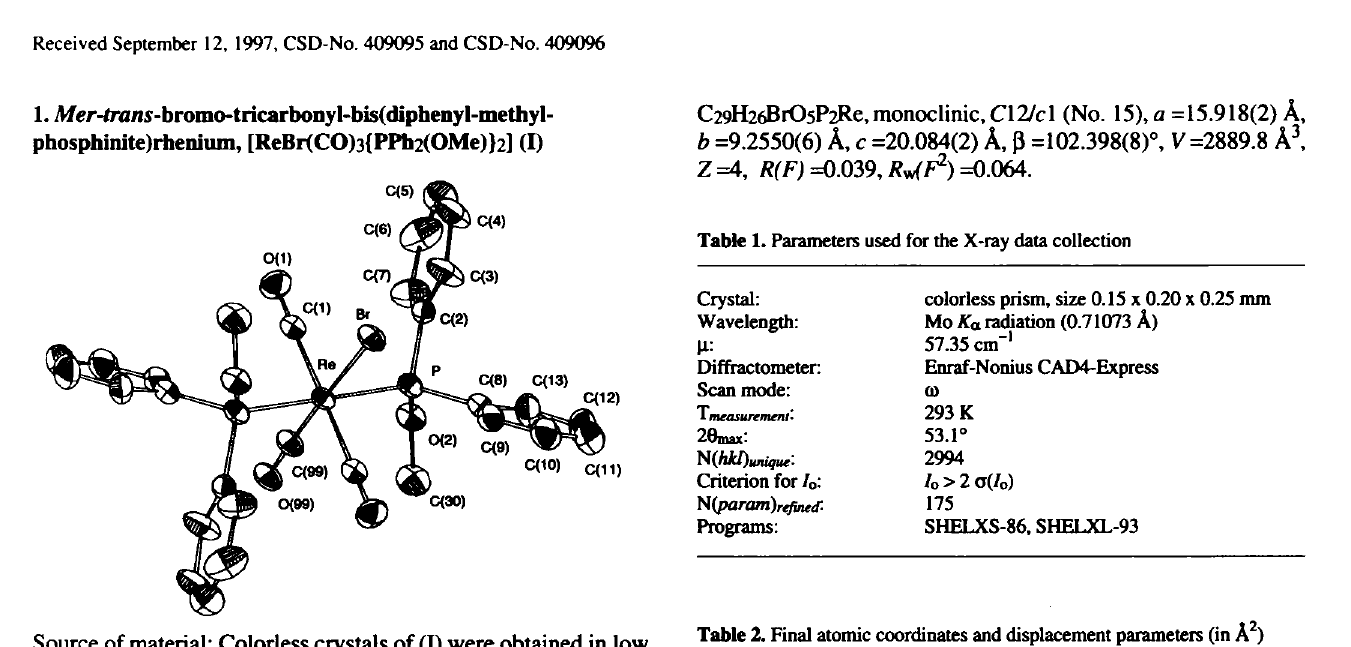
Table 2. Final atomic coordinates and displacement parameters (in